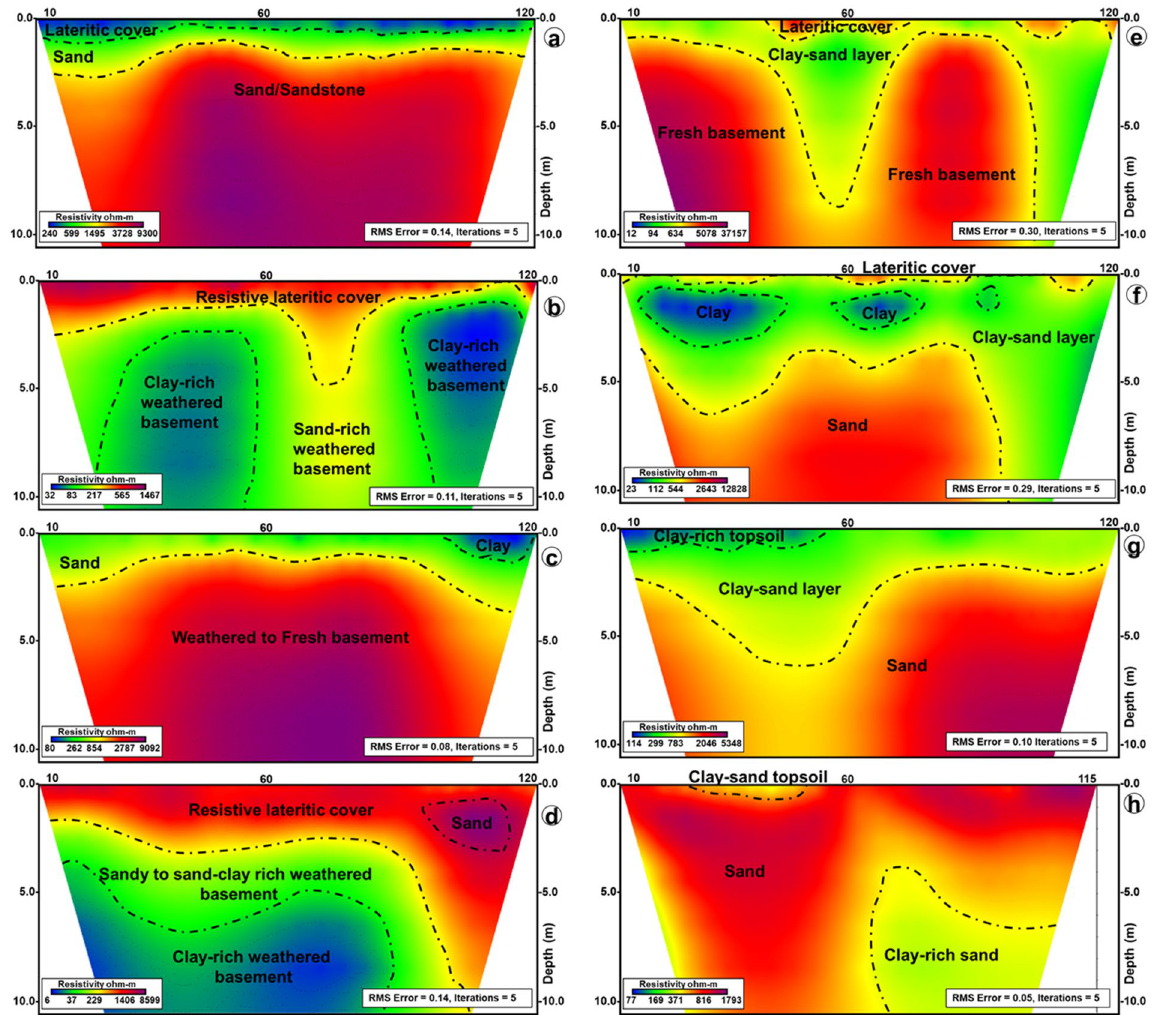
Figure 9. ERT pseudo sections showing the geoelectric layers (stratigraphy) of ( a ) Ago-Iwoye -Ijesha Ijebu 1, ( b ) Ago-Iwoye -Ijesha Ijebu 2, ( c ) Ago Iwoye-Imodi 1 and ( d ) Ago Iwoye-Imodi 2, ( e ) Atan -Erunwon Road